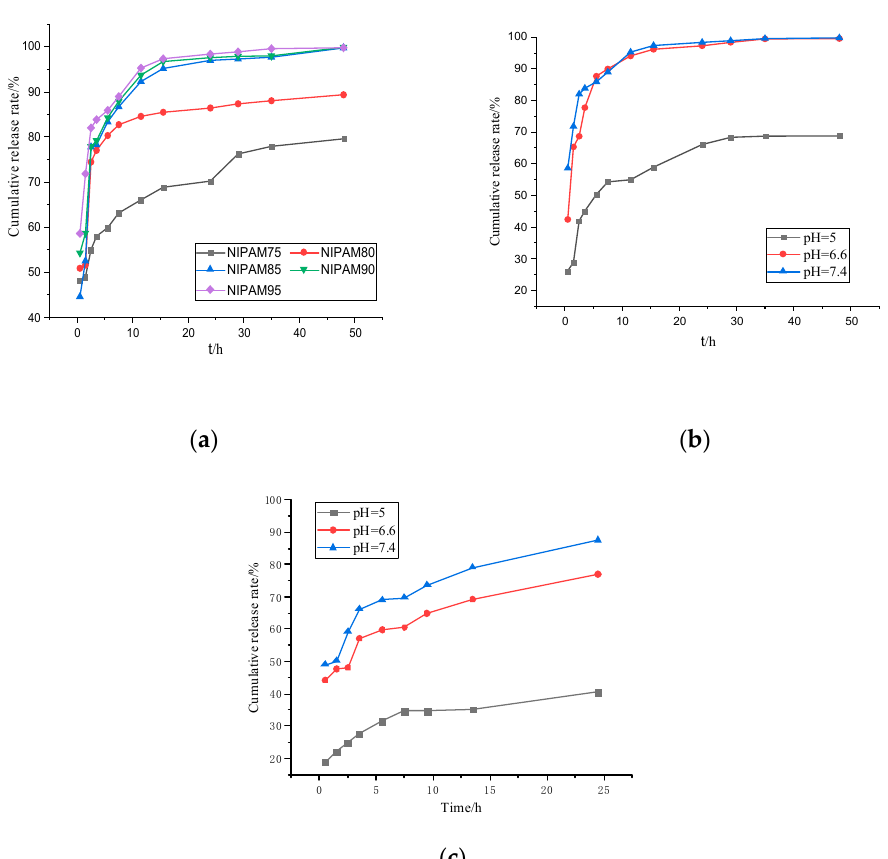
Figure 6. ( a ) The cumulative release rate of the encapsulated bovine serum albumin GA–P(NIPAM ‐ co ‐ DMAPMA) hydrogel. ( b ) The cumulative release rate of bovine serum albumin hydrogel in a buffer solution of pH = 7.4 at 37 °C. ( c ) The cumulative release rate of bovine serum albumin hydrogel varied with time at 25°C.